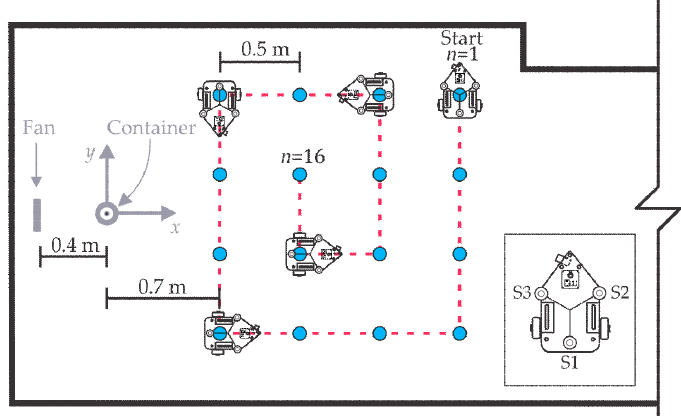
Figure 9. Room concentration mapping. The source location is unknown. The circles indicate the stops of the platform for data collection.